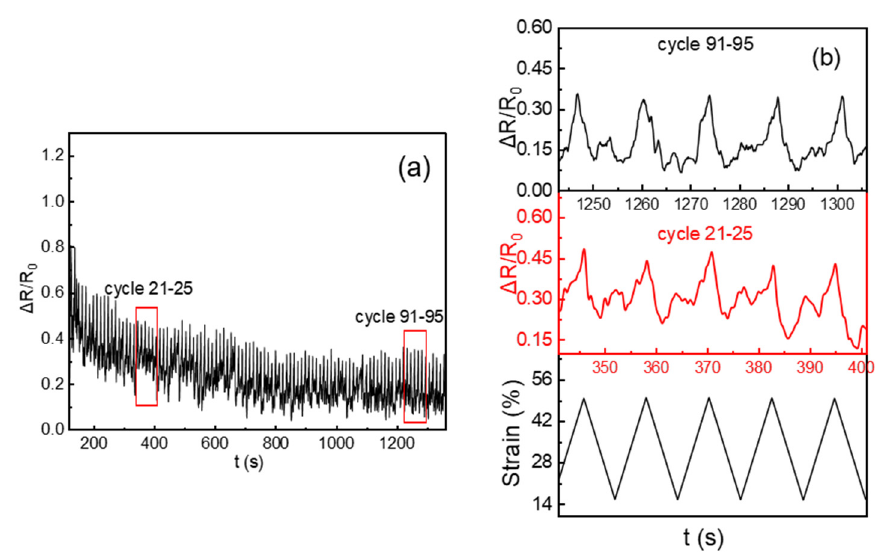
Figure 9. ( a ) normalized resistance change Δ R/R 0 -time curves in correspondence of strain varies from 15% to 50% of G1 0.06 -CNT 0.2 /PU composite; ( b ) Δ R/R 0 -time curves and tensile strain–time curve of G1 0.06 -CNT 0.2 /PU sensor.